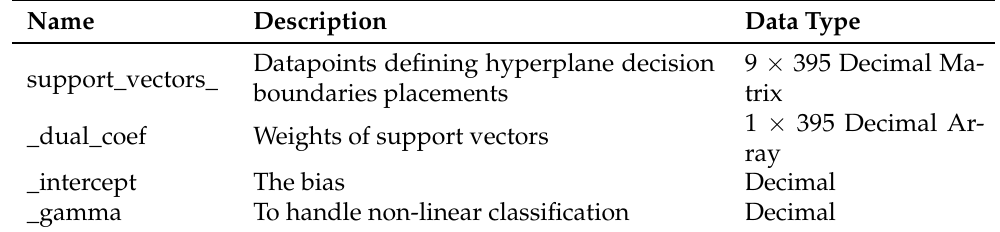
Table 2. SVM extracted parameters.